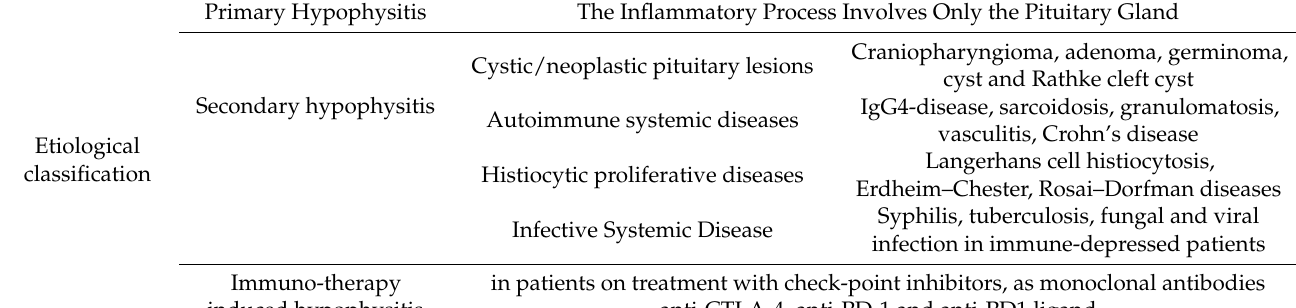
Table 1. Etiological classification of